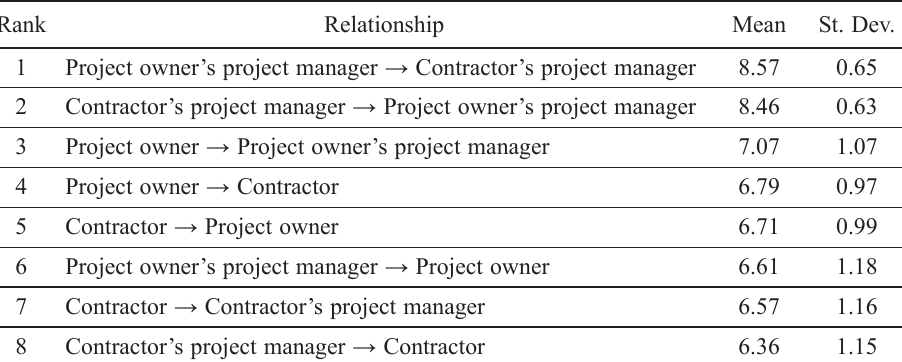
Table 2. Results of Delphi Round Three (Ceric